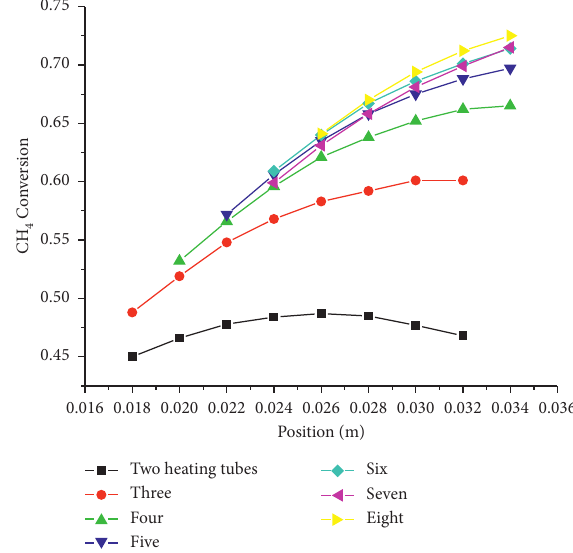
Figure 5: CH4 conversions for different heating tube configurations.